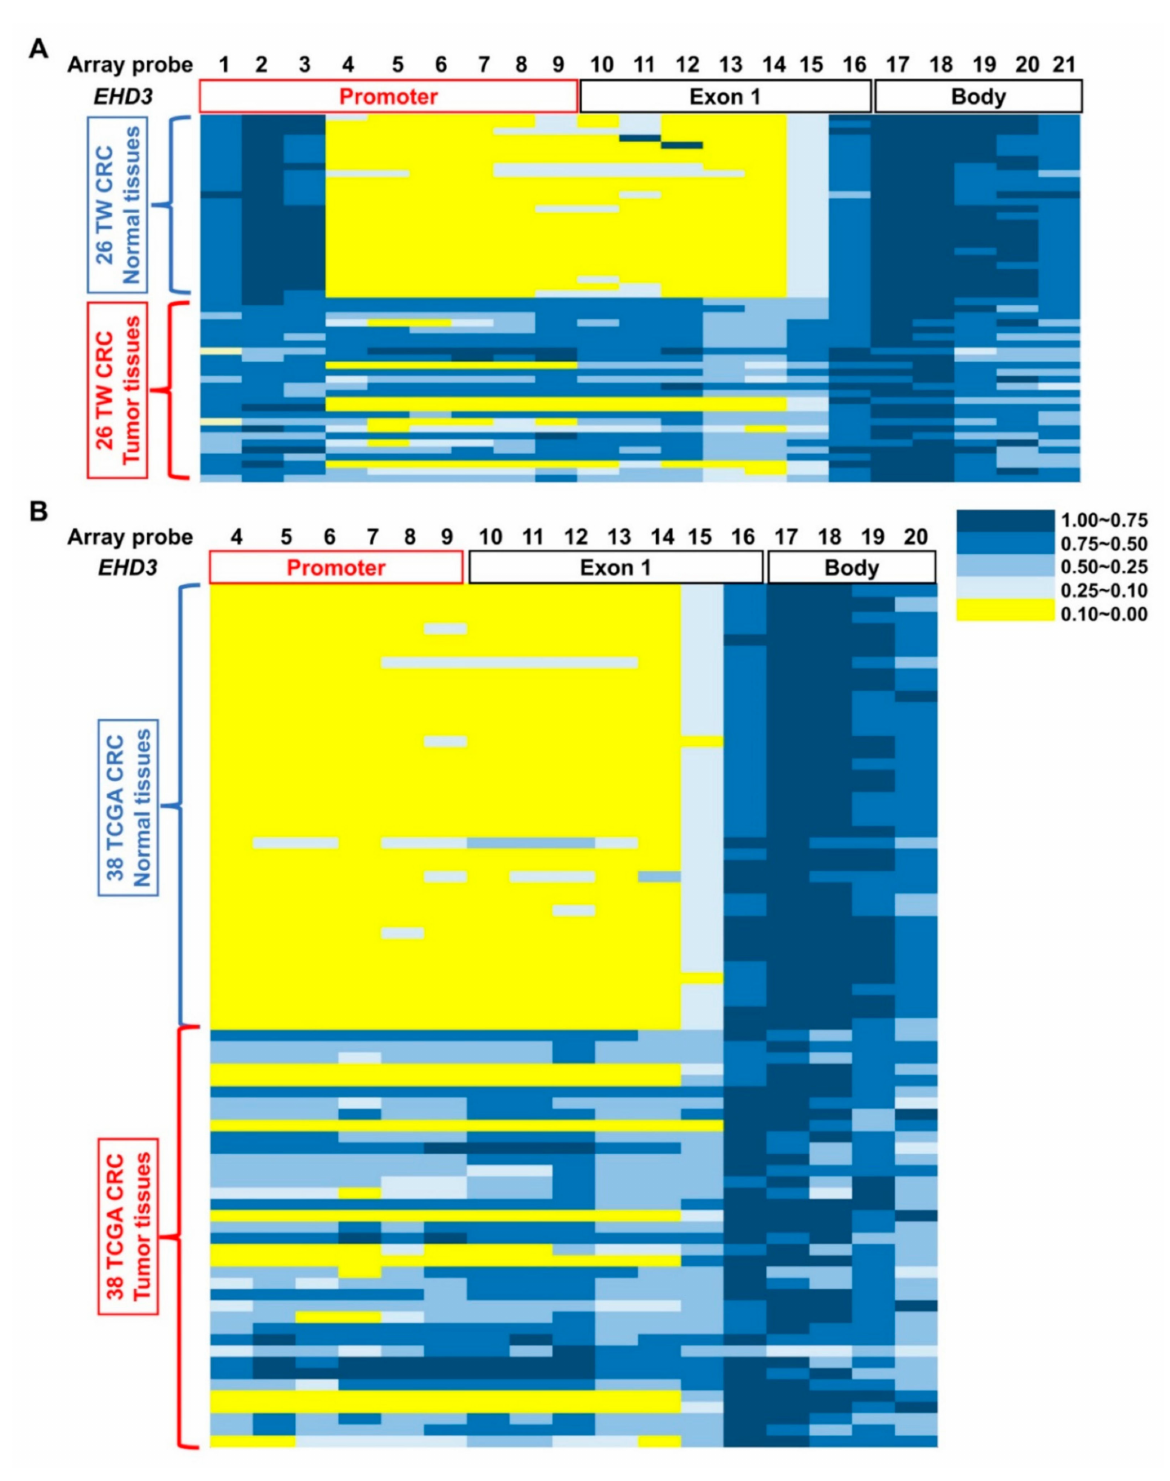
Figure 2. Different methylation at EHD3 CpG islands in patients with CRC. Methylation levels (average β values) at the differentially methylated loci were identified using an Illumina Methylation 450K array-based assay in ( A ) 26 patients with CRC in Taiwan and ( B ) 38 patients with CRC from the TCGA dataset. The scale shows the relative methylation status from 0.00 to 1.00 (yellow: hypomethylation, blue: hypermethylation). Twenty-one CpG sites on EHD3 were detected in 26 paired normal (upper) and CRC (lower) tissues, and array probes 1–21 were sites cg13149833, cg12045528, cg00648955, cg25202298, cg06773122, cg00981472, cg18444347, cg05882522, cg27230038, cg25428398, cg15355118, cg25840208, cg24743639, cg13795465, cg01163837, cg08251399, cg11957382, cg07185119, cg20203365, cg14018959, and cg14613979,